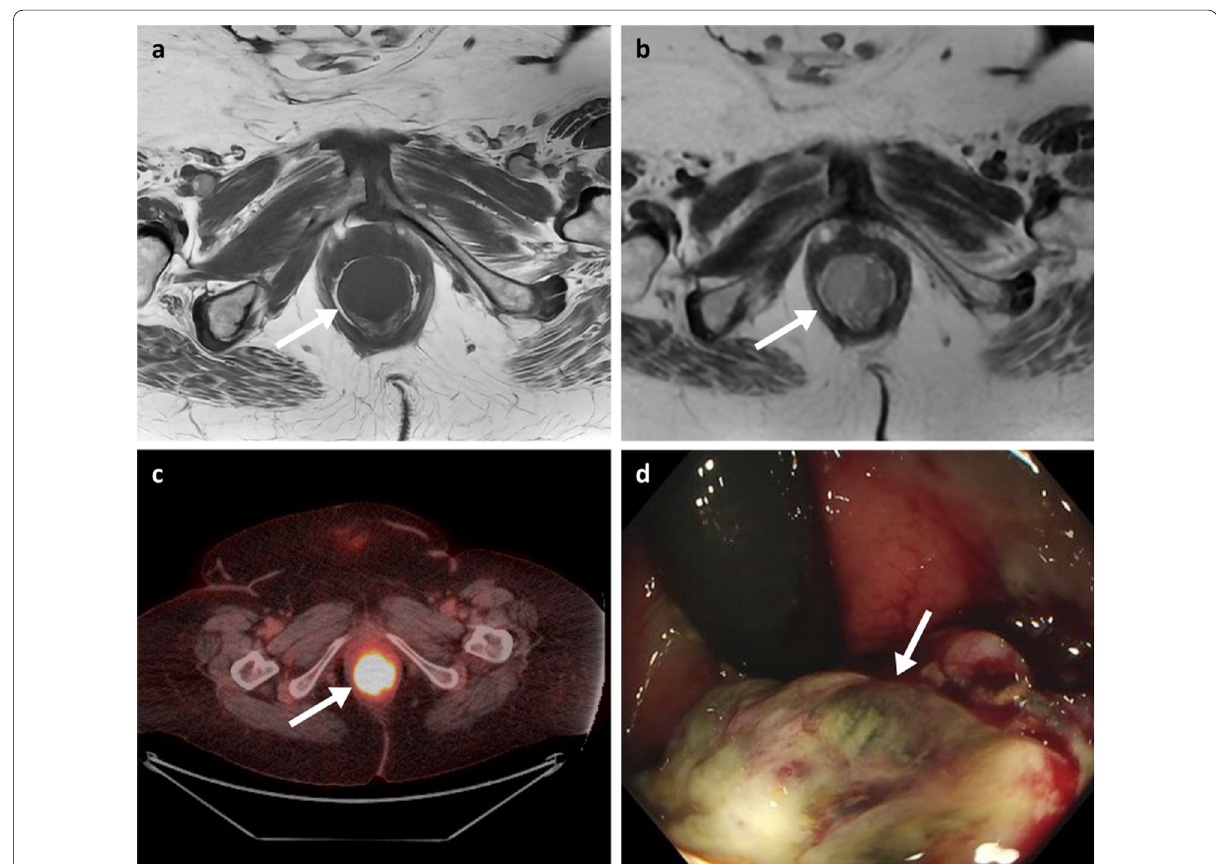
Fig. 13 MRI T1WI and T2WI axial ( a , b ), PET-CT axial ( c ) and flexible sigmoidoscopy ( d ) of a 71-year-old female patient with a metastatic melanoma anorectal mass (arrows). Black pigment is visible within the ulcerated part of the lesion on